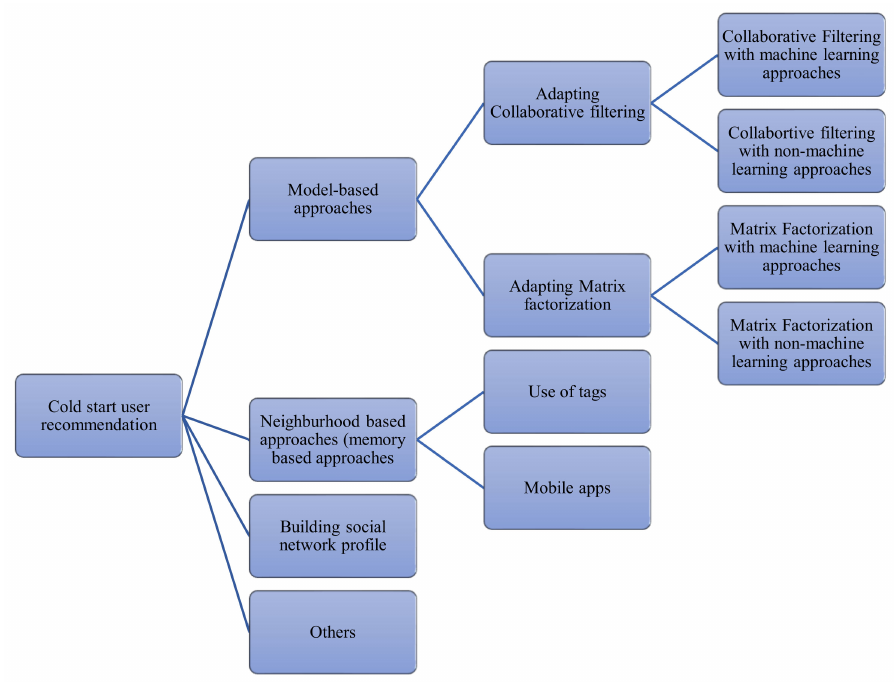
Figure 5. A taxonomy of the approaches for deriving and eliciting cold start user implicit